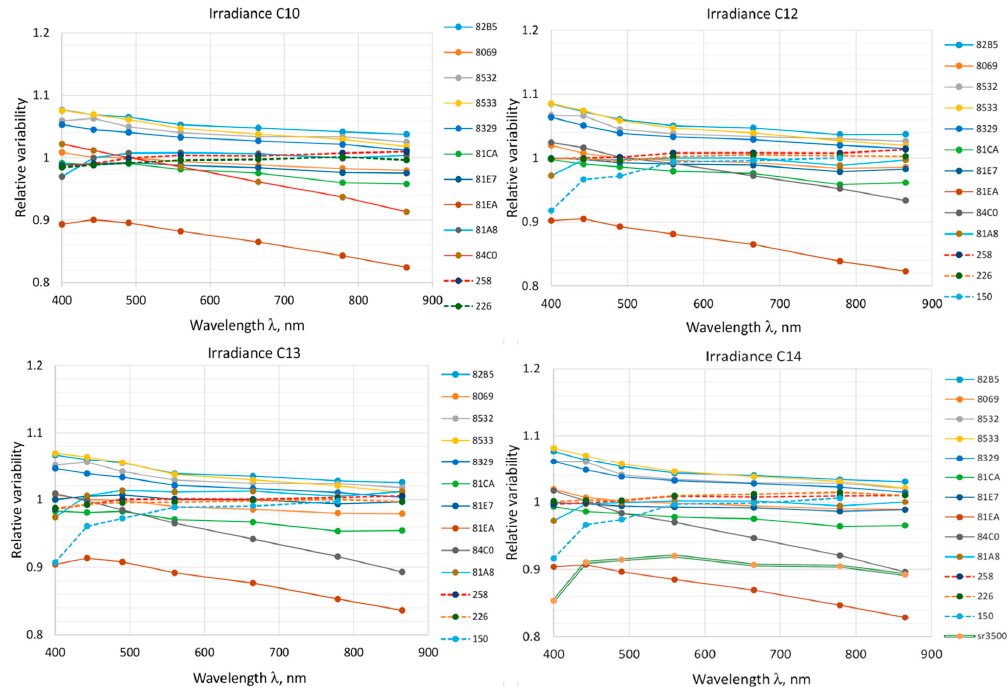
Figure 12. Irradiance sensors compared to the consensus value. Solid lines—RAMSES sensors; dashed lines—HyperOCR sensors; double line—SR-3500. Reproduced with permission from [46]. Relative uncertainty budget tables for the downwelling irradiance and water leaving radiance were also produced, based on the spread of individual sensors measuring the same target during the outdoor comparison [44,46]. Investigations to try to explain the marked differences between